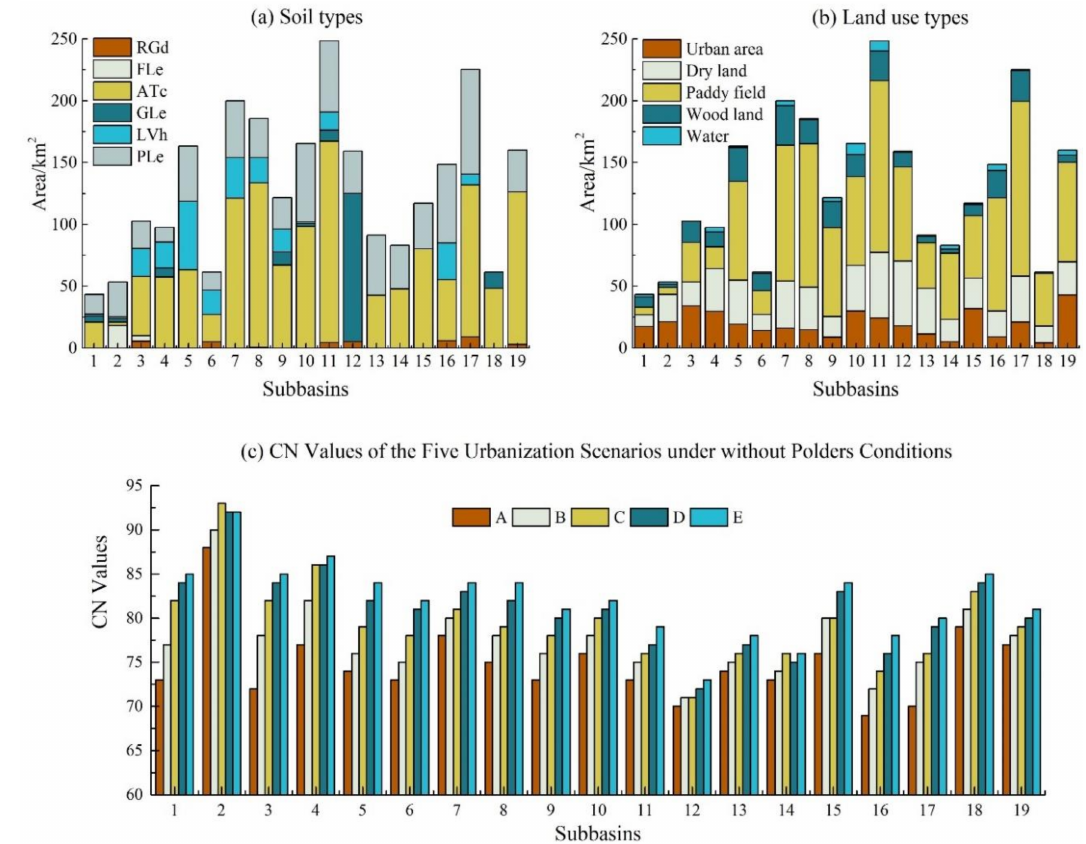
Figure 4. The areas of soil types and land uses in the sub basins of the Qinhuai River basin (scenario B) and the CN values of the five urbanization scenarios under without polder conditions( a ) soil